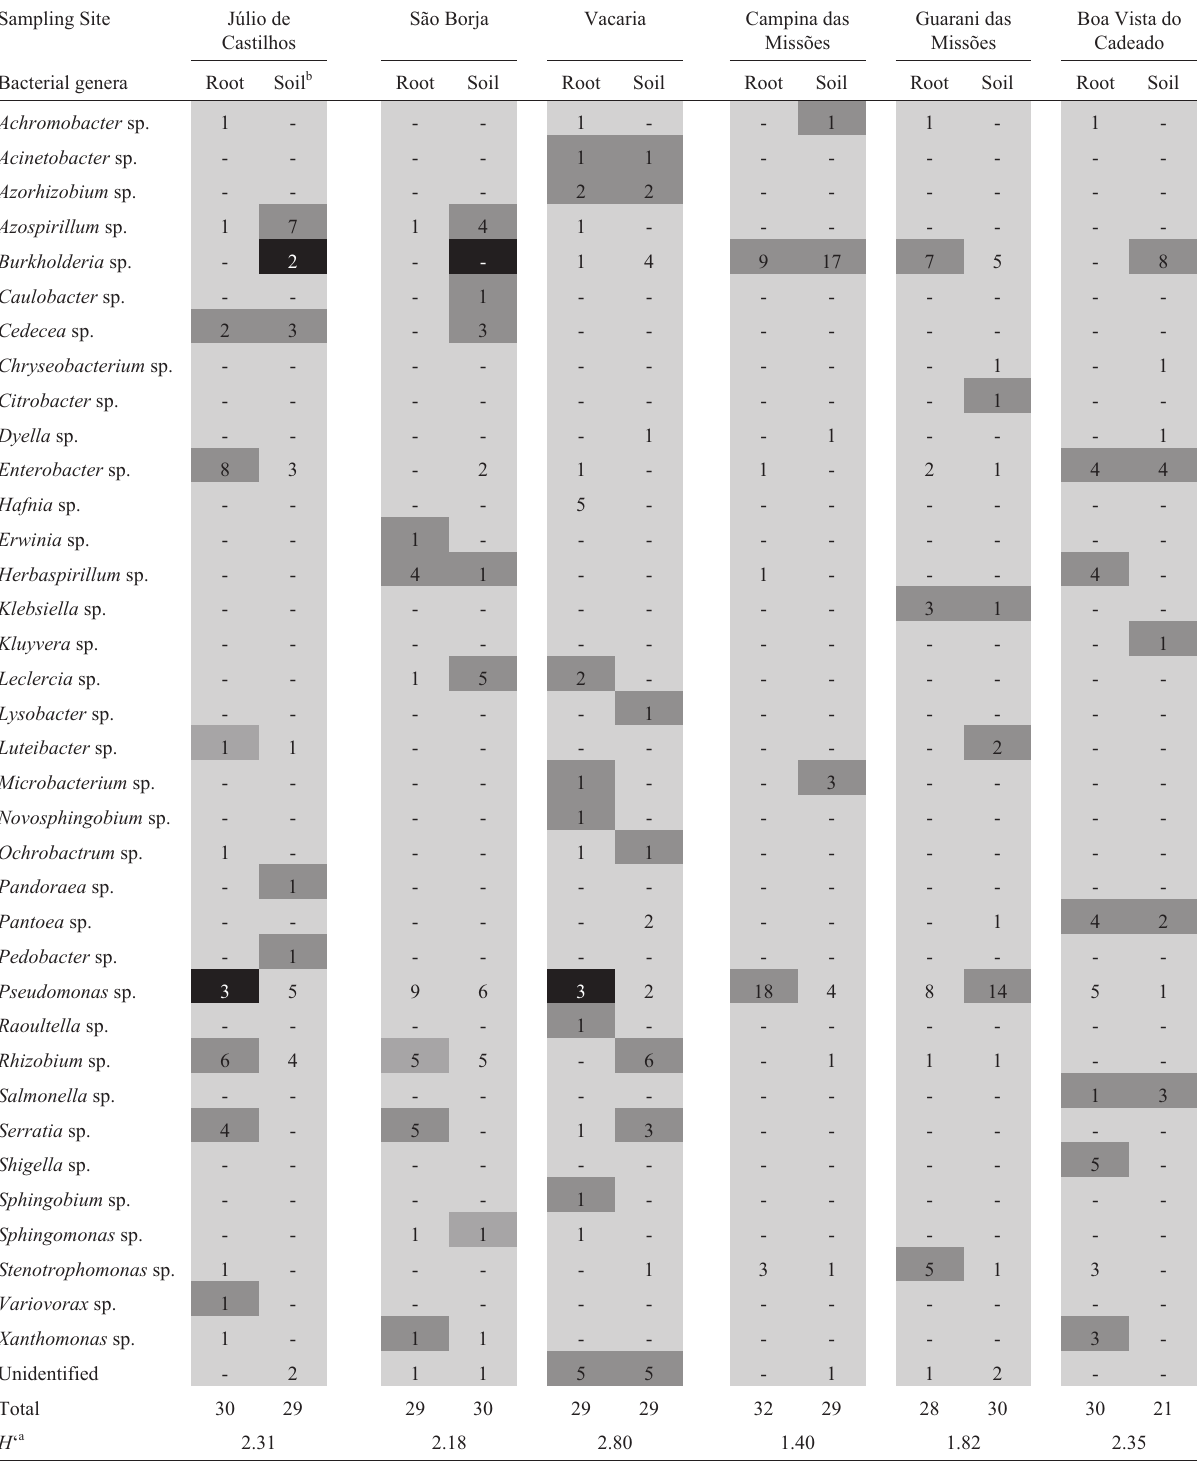
Table 2 - Heatmap associations of bacterial genera and occurrence of putative endophytic (Root) and rhizospheric (Soil) isolates. Different shades show whether a certain location had more or fewer bacteria, than expected, or whether there was no association. Black cells = number of isolates lower than ex- pected in that condition; dark shaded cells = number of isolates higher than expected in that condition; light shaded cells = no significant differences be- tween observed and expected values. “–” = association could not be calculated due to lack of cases (no comparable expected total marginal values), ac- cording to adjusted residual analysis ( p <0.05)